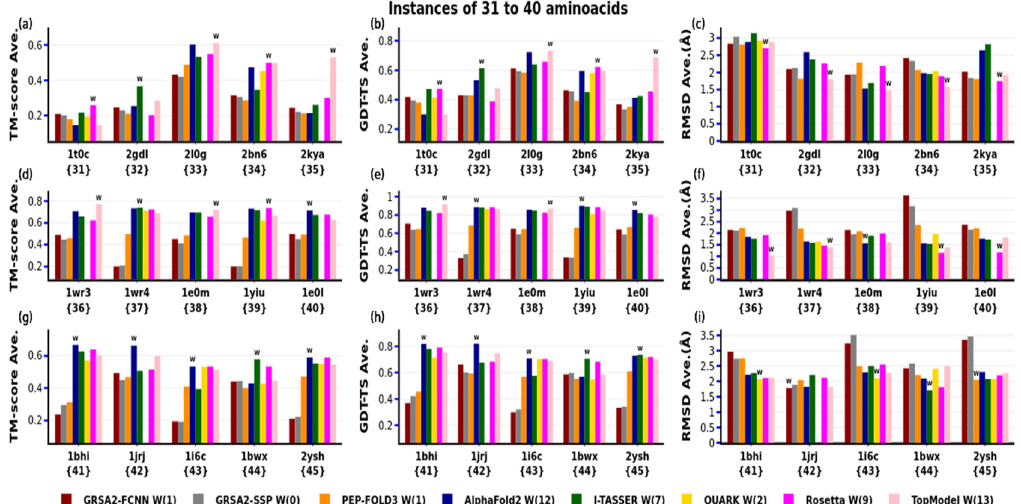
Figure 8. Comparison of GRSA2-FCNN versus I-TASSER, AlphaFold2, Rosetta, QUARK, PEP-FOLD3, TopModel, and GRSA2-SSP (from 31 to 40 aa). ( a , d , g ) show the average of the five best predictions of TM-score; ( b , e , h ) present their corresponding GDT-TS metric for each instance; ( c , f , i ) display the RMSD results.